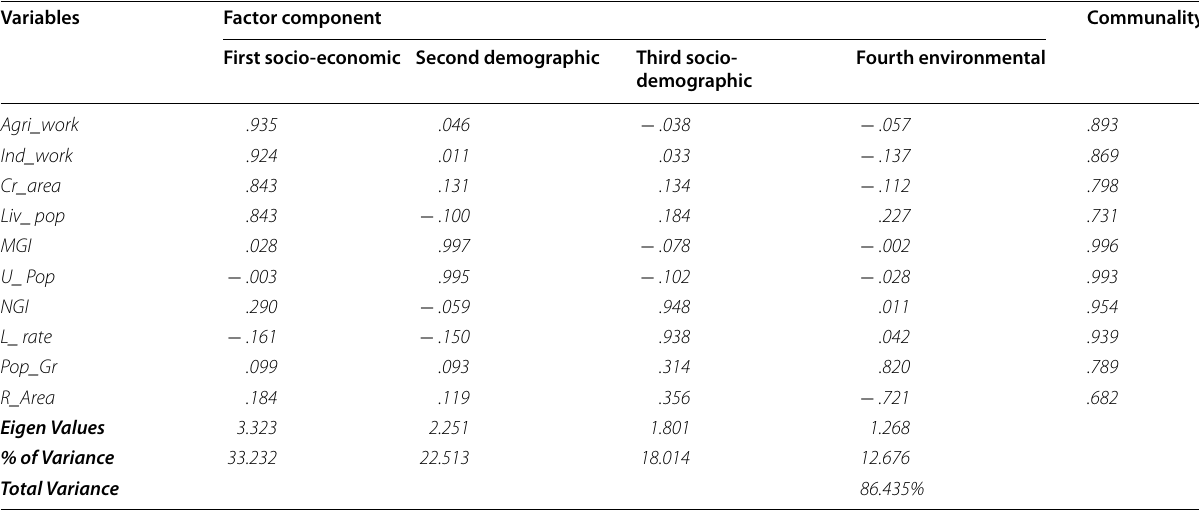
Table 3 Obliquely rotated component